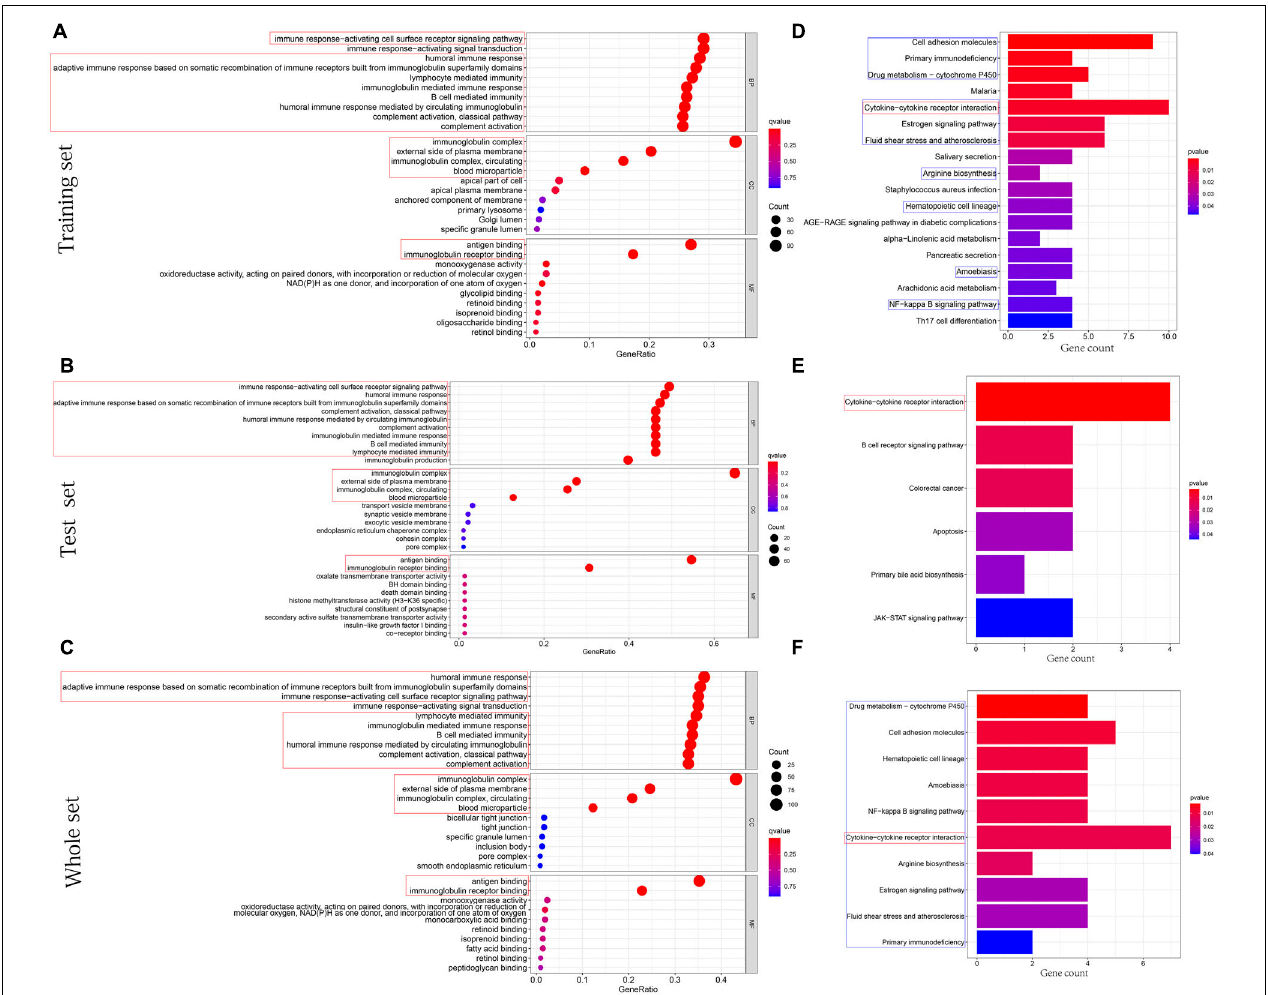
FIGURE 7 | Functions and pathways enrichment DEGs participated in. (A–C) The bubble chart, respectively, shows the BPs, CCs, and MFs enriched by GO in training, test, and whole sets. (D–F) The histogram, respectively, shows the pathways enriched by KEGG in training, test, and whole sets. The size of the circle represents the number of DEGs enriched on each GO. The color of the circle or cuboid represents the significance of